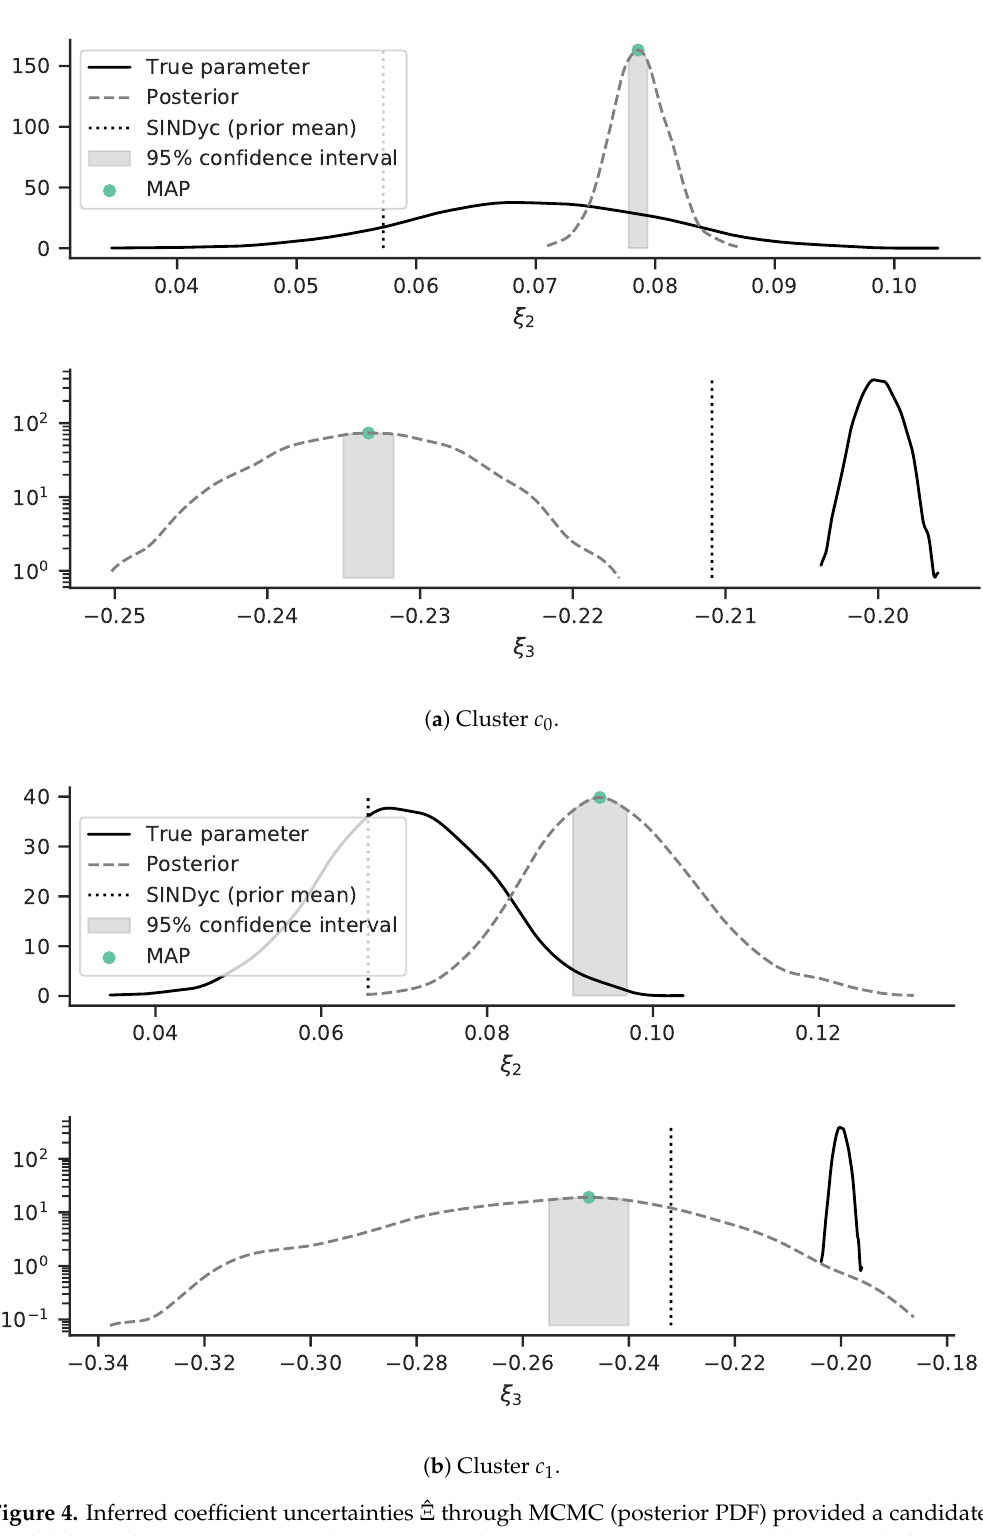
Figure 4. Inferred coefficient uncertainties ˆ Ξ through MCMC (posterior PDF) provided a candidate model derived using SINDyc and n obs system observation sequences. Dotted lines mark the prior means based on the chosen SINDyc models. The maximum of the posterior distribution (MAP) is marked. The 95% confidence interval is marked using the shaded